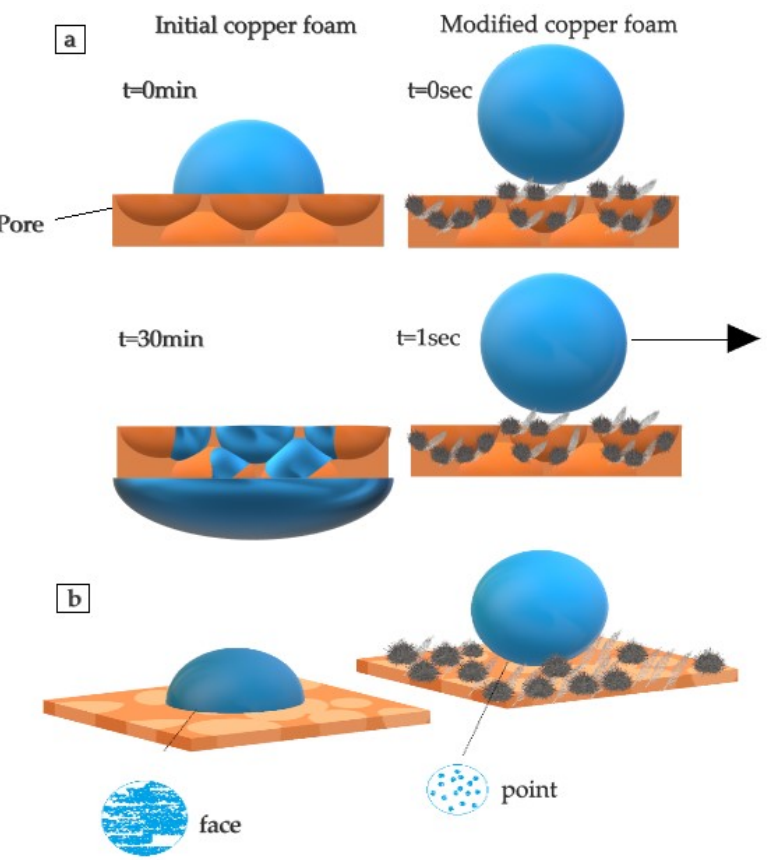
Figure 10. ( a ) Schematic diagram of wetting repellency mechanism ( b ) illustration of contact areas for a pristine (initial) and modified copper